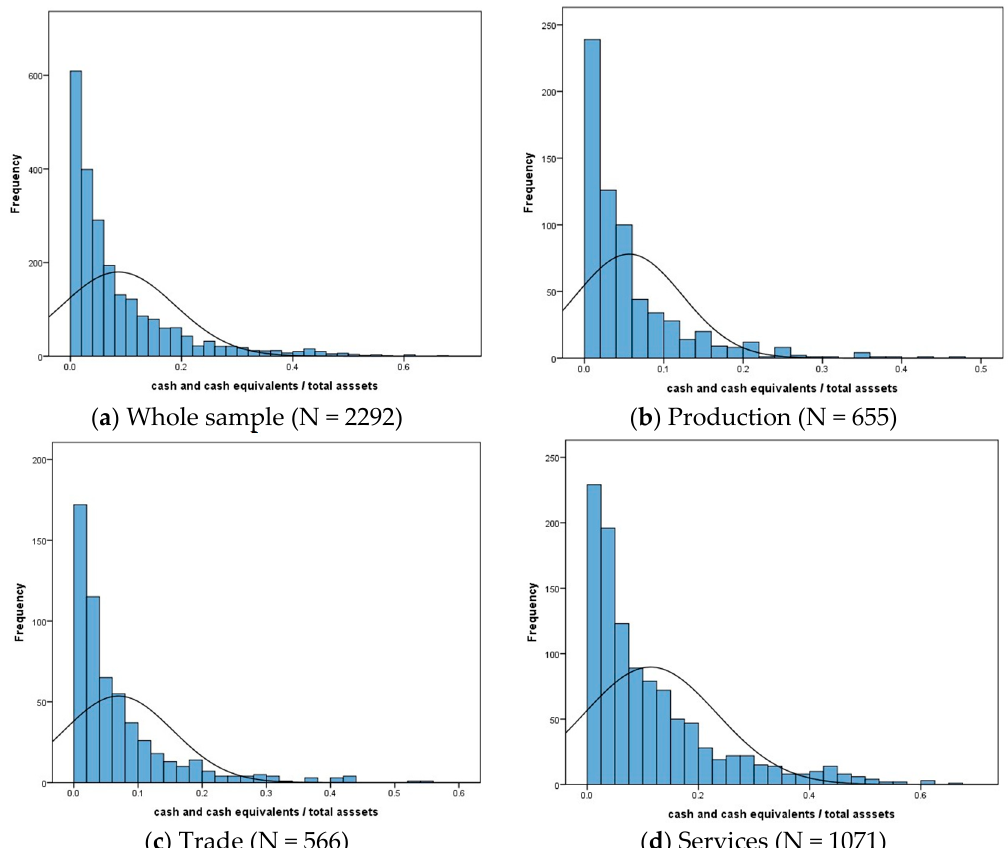
Figure A1. Distribution plots for liquidity constraints (Cash and cash equivalents to assets).